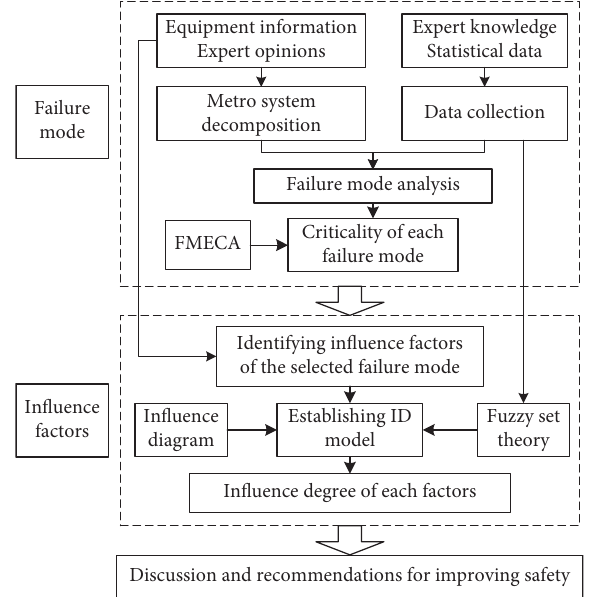
Figure 2: The analytical